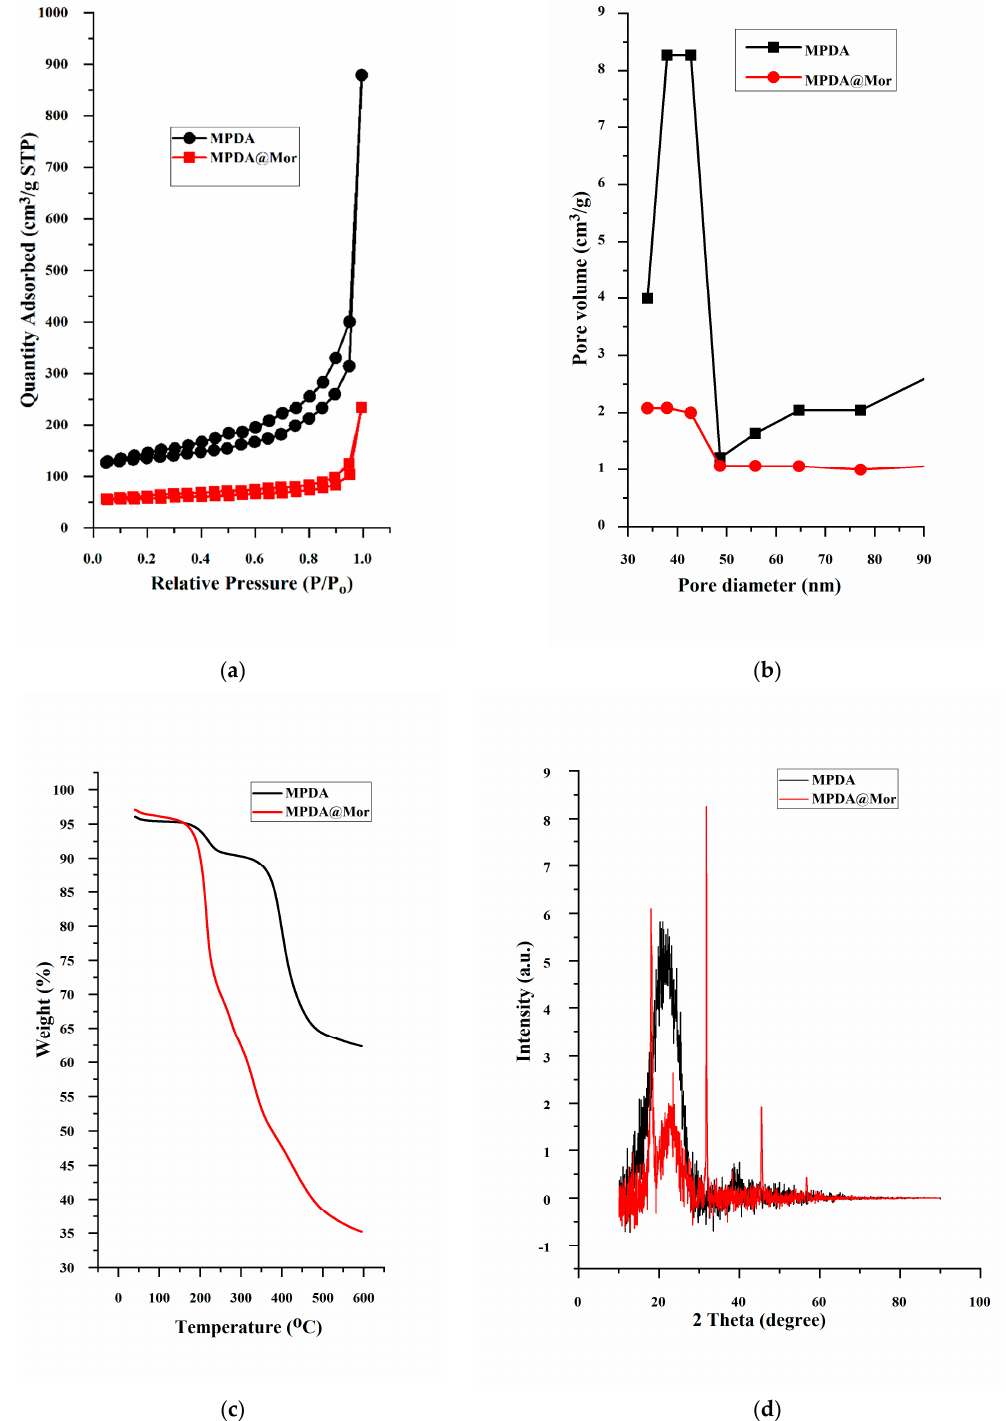
Figure 3. ( a ) Nitrogen adsorption–desorption isotherms, ( b ) pore size distribution, ( c ) thermogravimetric analysis and ( d ) powder X-ray diffraction patterns of MPDA and MPDA@Mor.